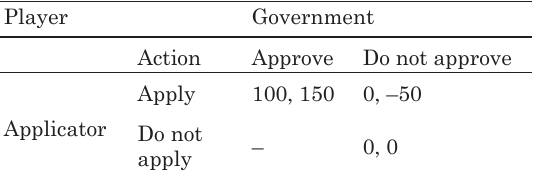
table 1. applying for economically affordable house: qualified applicator ( Type 1)